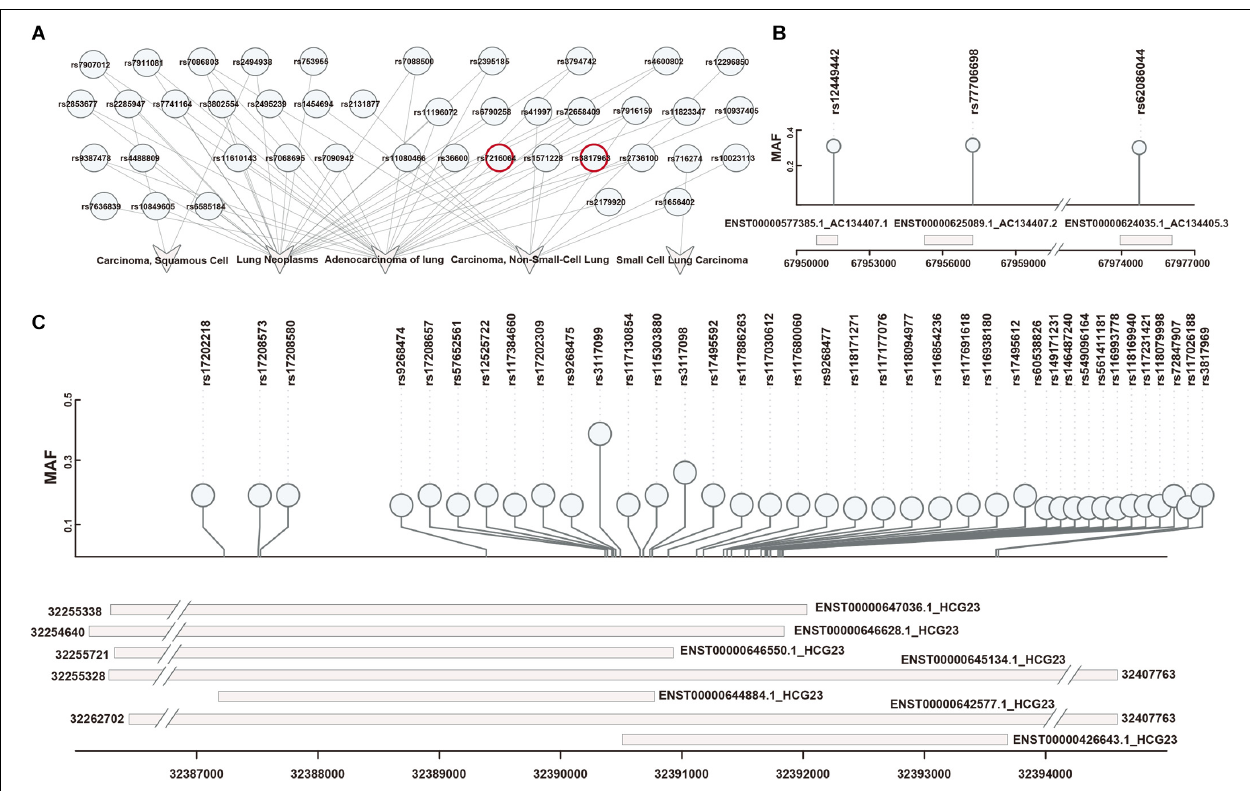
FIGURE 2 | Obtaining and repositioning of LD SNPs. (A) Lung-disease-associated SNPs were downloaded in dbGap. SNPs in red represented their linkage disequilibrium SNPs mapped on lncRNAs. (B) The one-to-one relationships of LD SNPs and lncRNA transcripts based on a short-sequence alignment algorithm. (C) The corresponding locations of LD SNPs mapped onto lncRNA